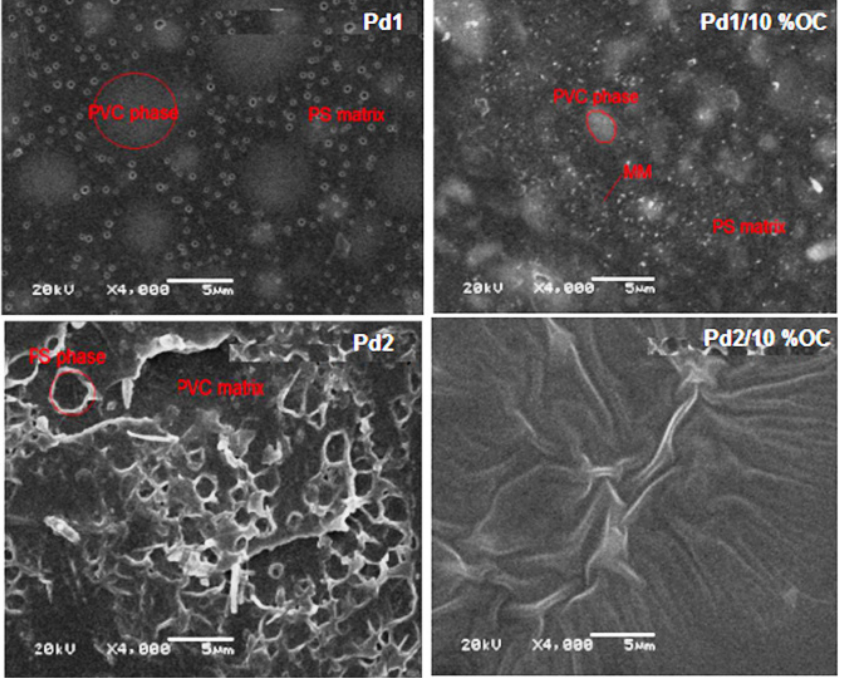
Figure 8: Scanning Electron Microscope(SEM) images of Pd1(PS/PVA:10/90), Pd1/10 % Organoclay(OC),Pd2( PS/PVA:90/10) and Pd2/10%